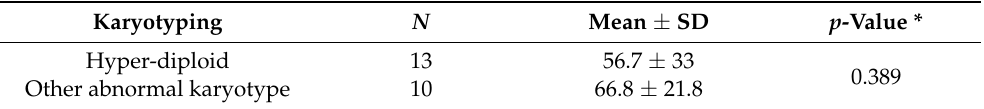
Table 3. Comparison between karyotyping categories with regard to CD200 expression. Karyotyping N Mean ± SD p -Value *